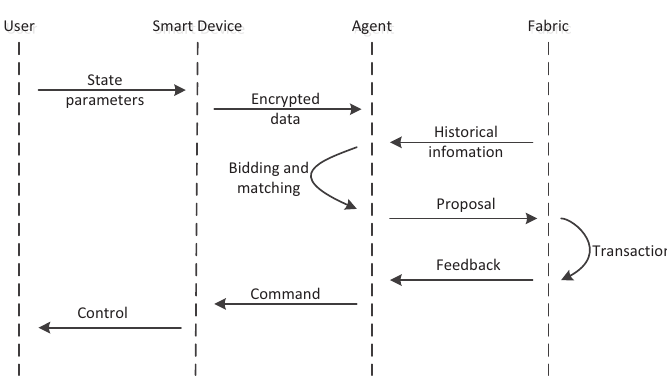
Figure 5. Sequence diagram of HBTS.